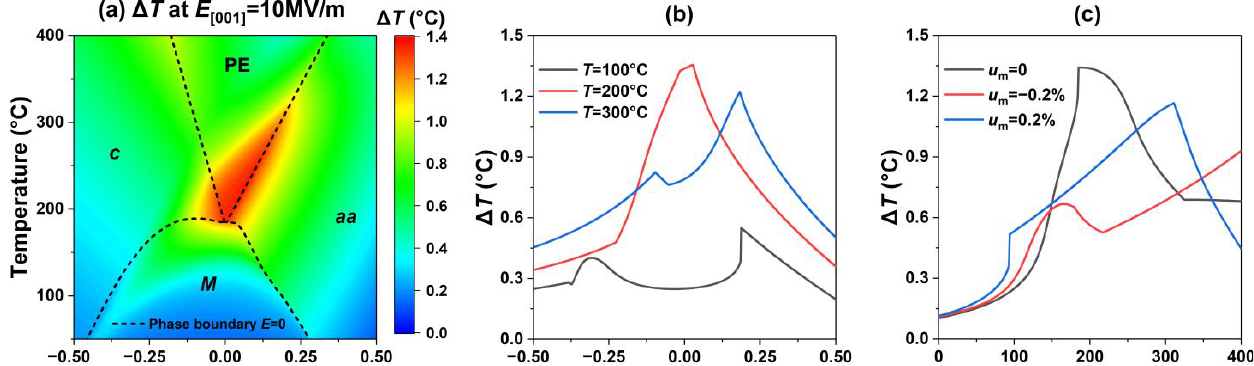
Figure 4. ( a ) The electrocaloric temperature change ∆ T as a function of misfit strain and temperature under an electric field change ∆ E = 10 MV/m. ( b ) The corresponding ∆ T at a fixed temperature. ( c ) The corresponding ∆ T at fixed misfit